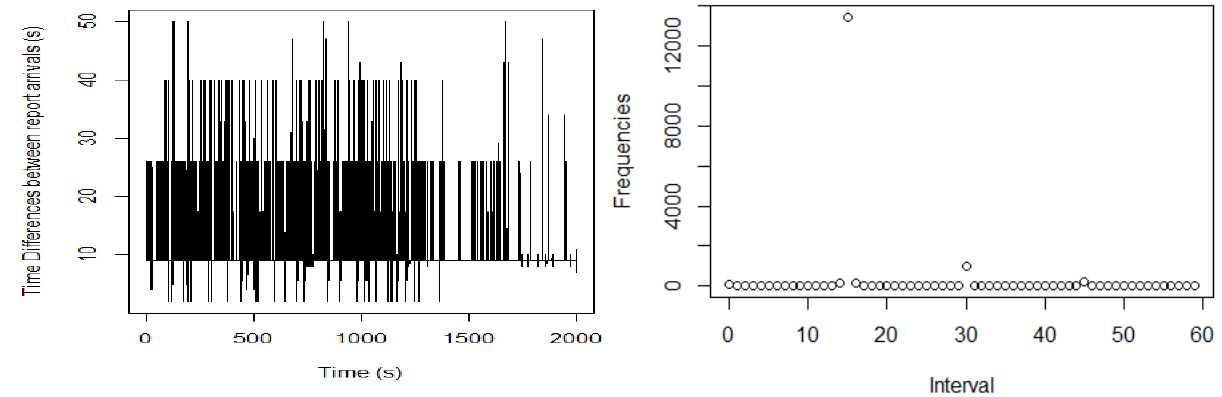
Figure 11 . Left : Normal plot, middle : histogram and right : whisker plot for temperature values over a period from 17 th to 20 th August 2018, with a reporting interval of 15 seconds. The distribution of temperature data indicates a normal distribution with the majority of readings appearing between 18 and 24. The assessment discovered no outliers in data values and gradual increases and decreases are observed. Unless